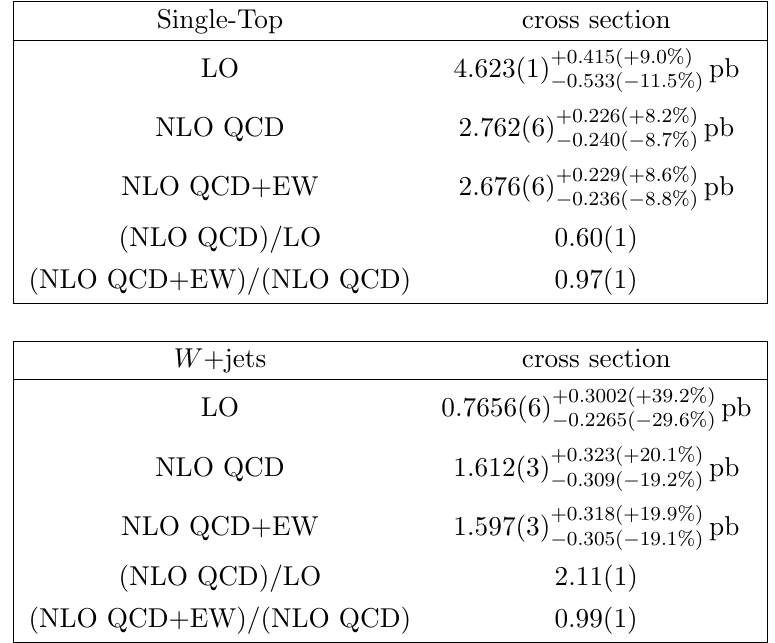
Table 2 . Various (cid:12)xed-order cross sections (in pb), including their scale uncertainty, for the signature (2.1) within the (cid:12)ducial region de(cid:12)ned in section 3.1 for the Single-Top process (top table) and the W +jets process (bottom table). The ratios (last two lines of both tables) are computed for the central values of the corresponding